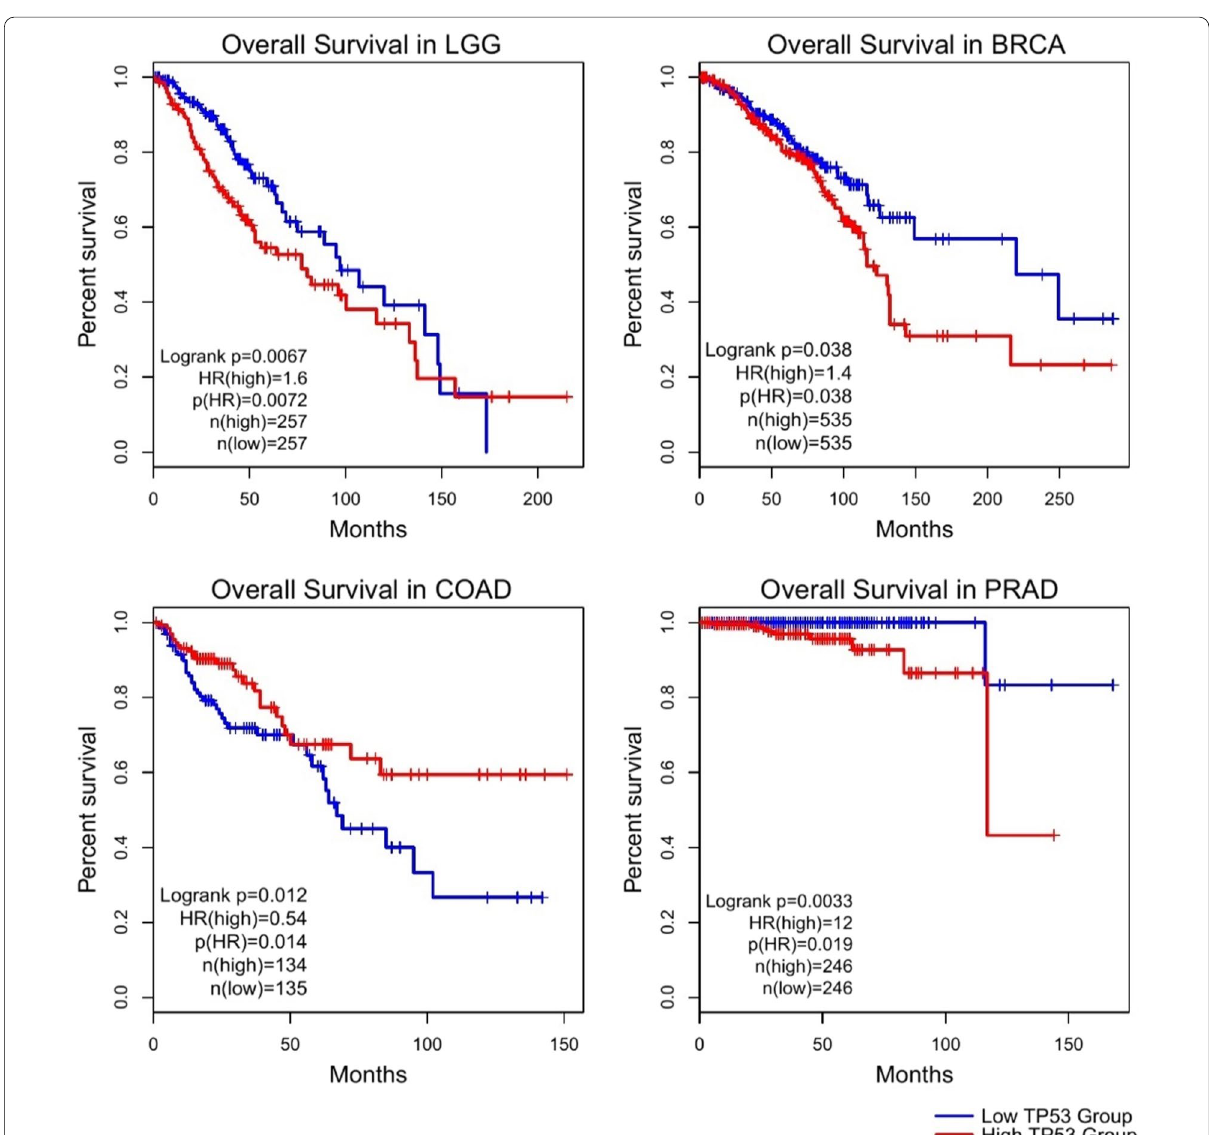
Fig. 7 Survival analysis plot of p53 in LGG, BRCA, COAD, and PRAD expressing the correlation of p53 expression with patients’ survival period